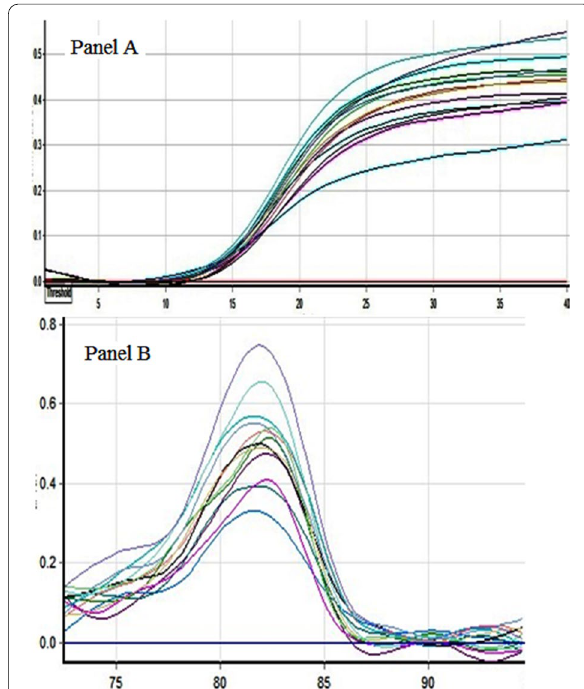
Fig. 4 Linear amplification plots (panels A ) and melting curves (panel B ) for aphIV gene in selected samples. A The cycle number is plotted on the X ‑axis versus the measured fluorescence increase on the Y ‑axis. B The temperature (°C) is plotted on the X ‑axis versus the measured fluorescence variation (d F /d T ) on the Y ‑axis